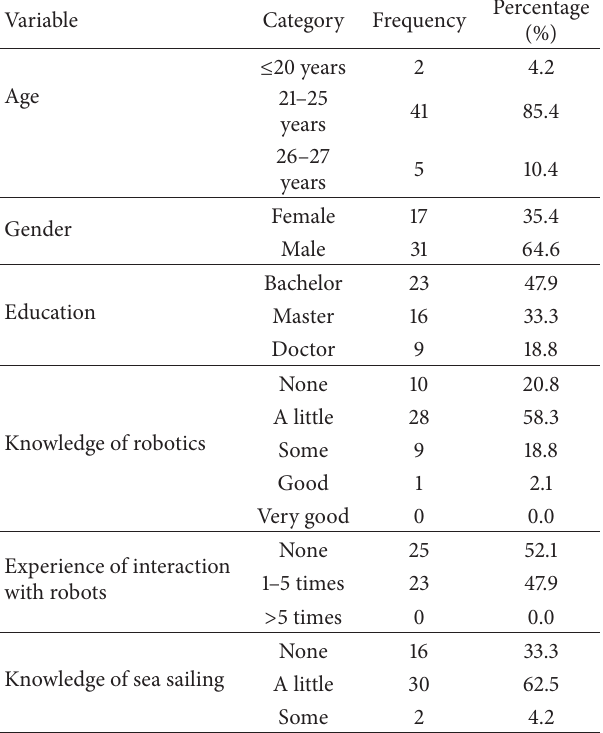
Table 2: Background information of participants.